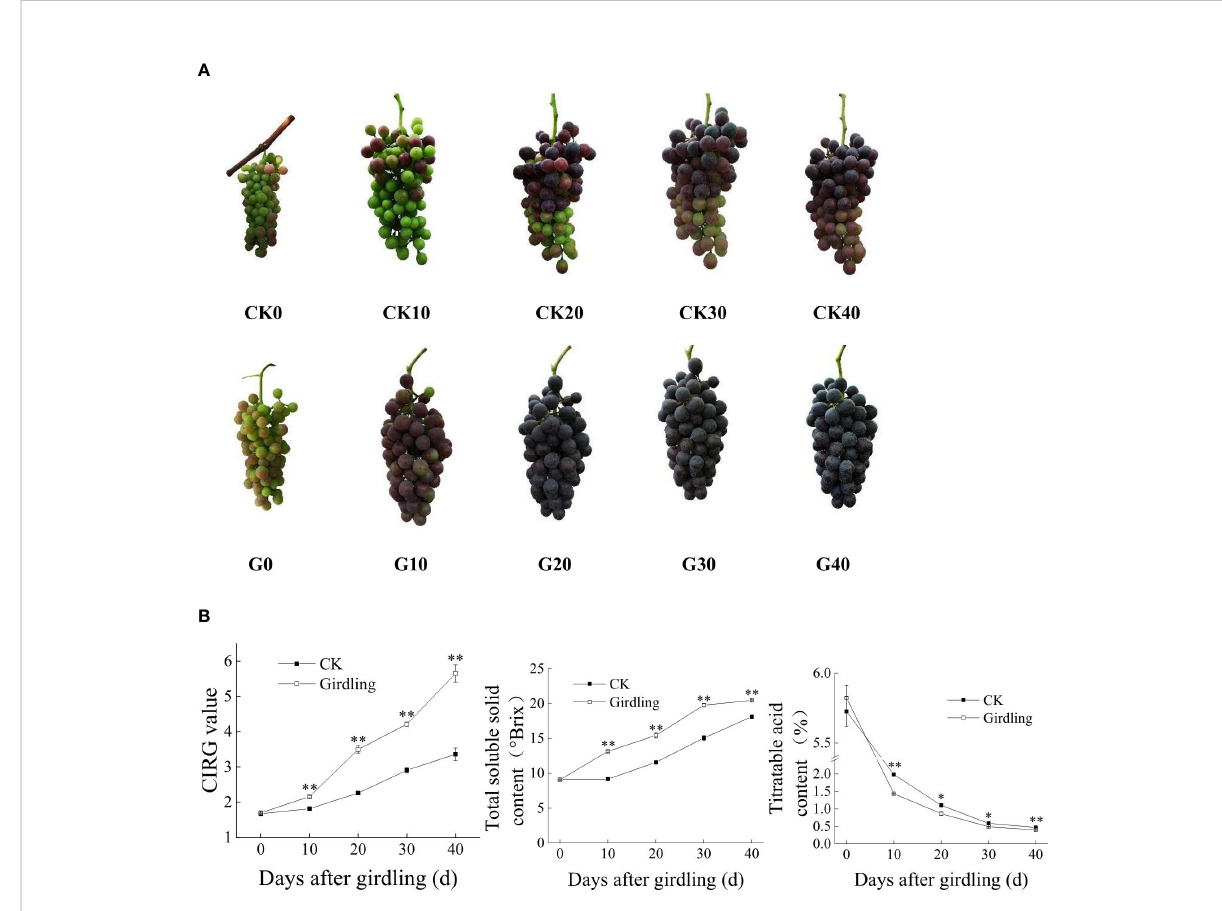
FIGURE 1 Berry development of ‘ Summer Black ’ after girdling treatment. (A) Bunches of the girdling and control groups on days 0, 10, 20, 30, and 40 after treatment. (B) CIRG value and TSS and TA contents of berries at each time point. *p < 0.05, **p < 0.001 vs. control on the same day (t-test). CIRG, color index of red grapes; TSS, total soluble solid; TA, titratable